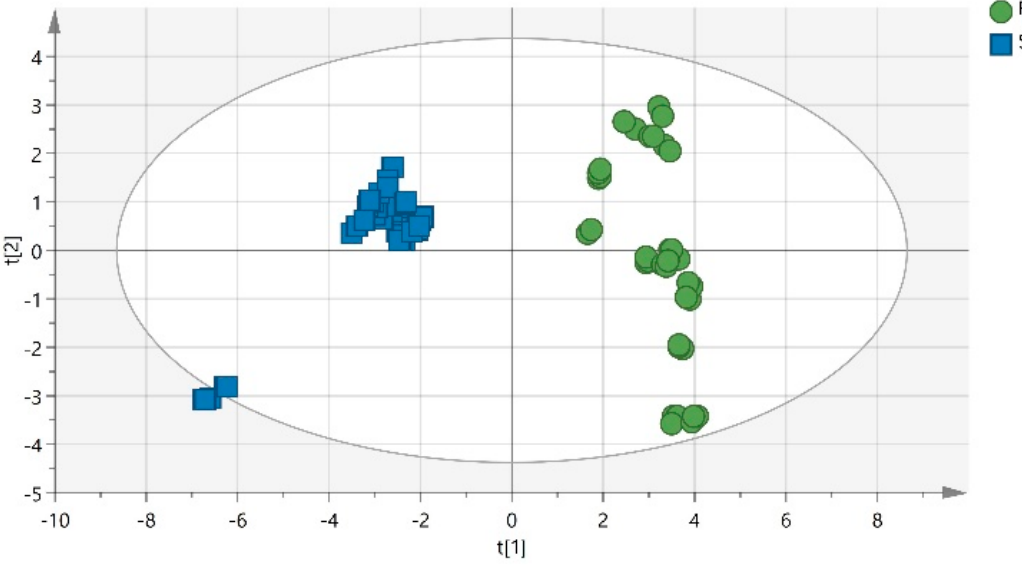
Figure 1. PCA scatter plot for 76 carob samples (R 2 X (cum) = 0.72, Q 2 (cum) = 0.50).